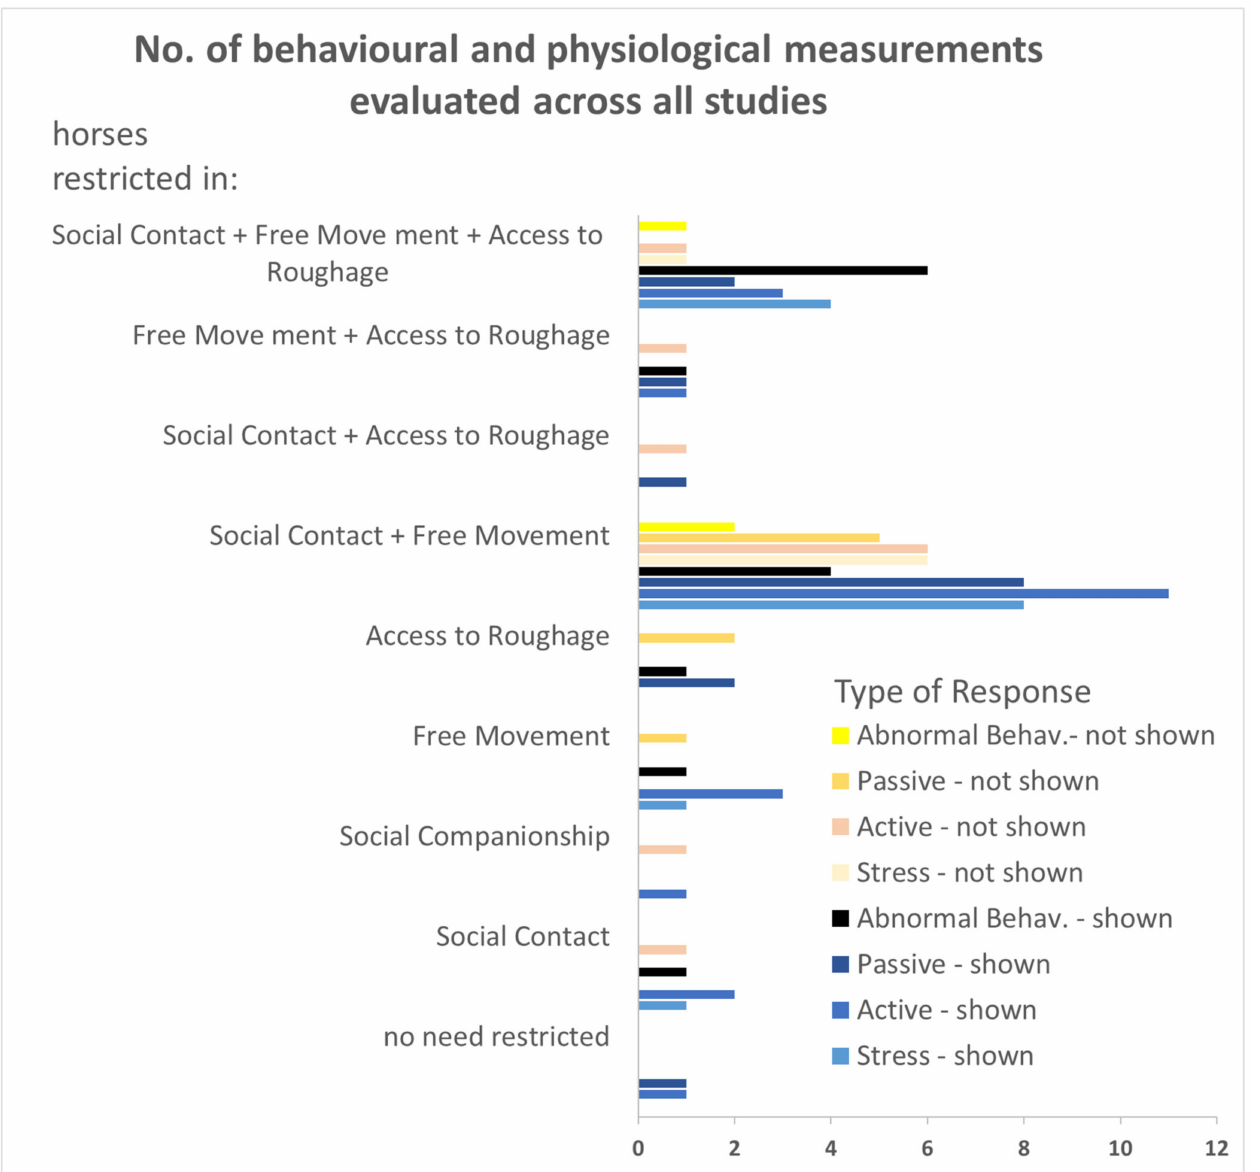
Figure 1. Number of reports of responses (dark colours, i.e., black and blue) versus number of reports of no response (light colours: skin and yellow) to restrictions in proposed “basic needs” described for response types across all studies. Abnormal Behaviour responses were significantly shown across all studies (Binomial Test: p = 0.02). Responses were also shown when social contact, free movement and access to roughage were mutually restricted (Binomial Test: p < 0.001). More detailed information on the responses, the test conditions and the horses included in the studies are given in Table 1 and in the Supplementary Materials (Table